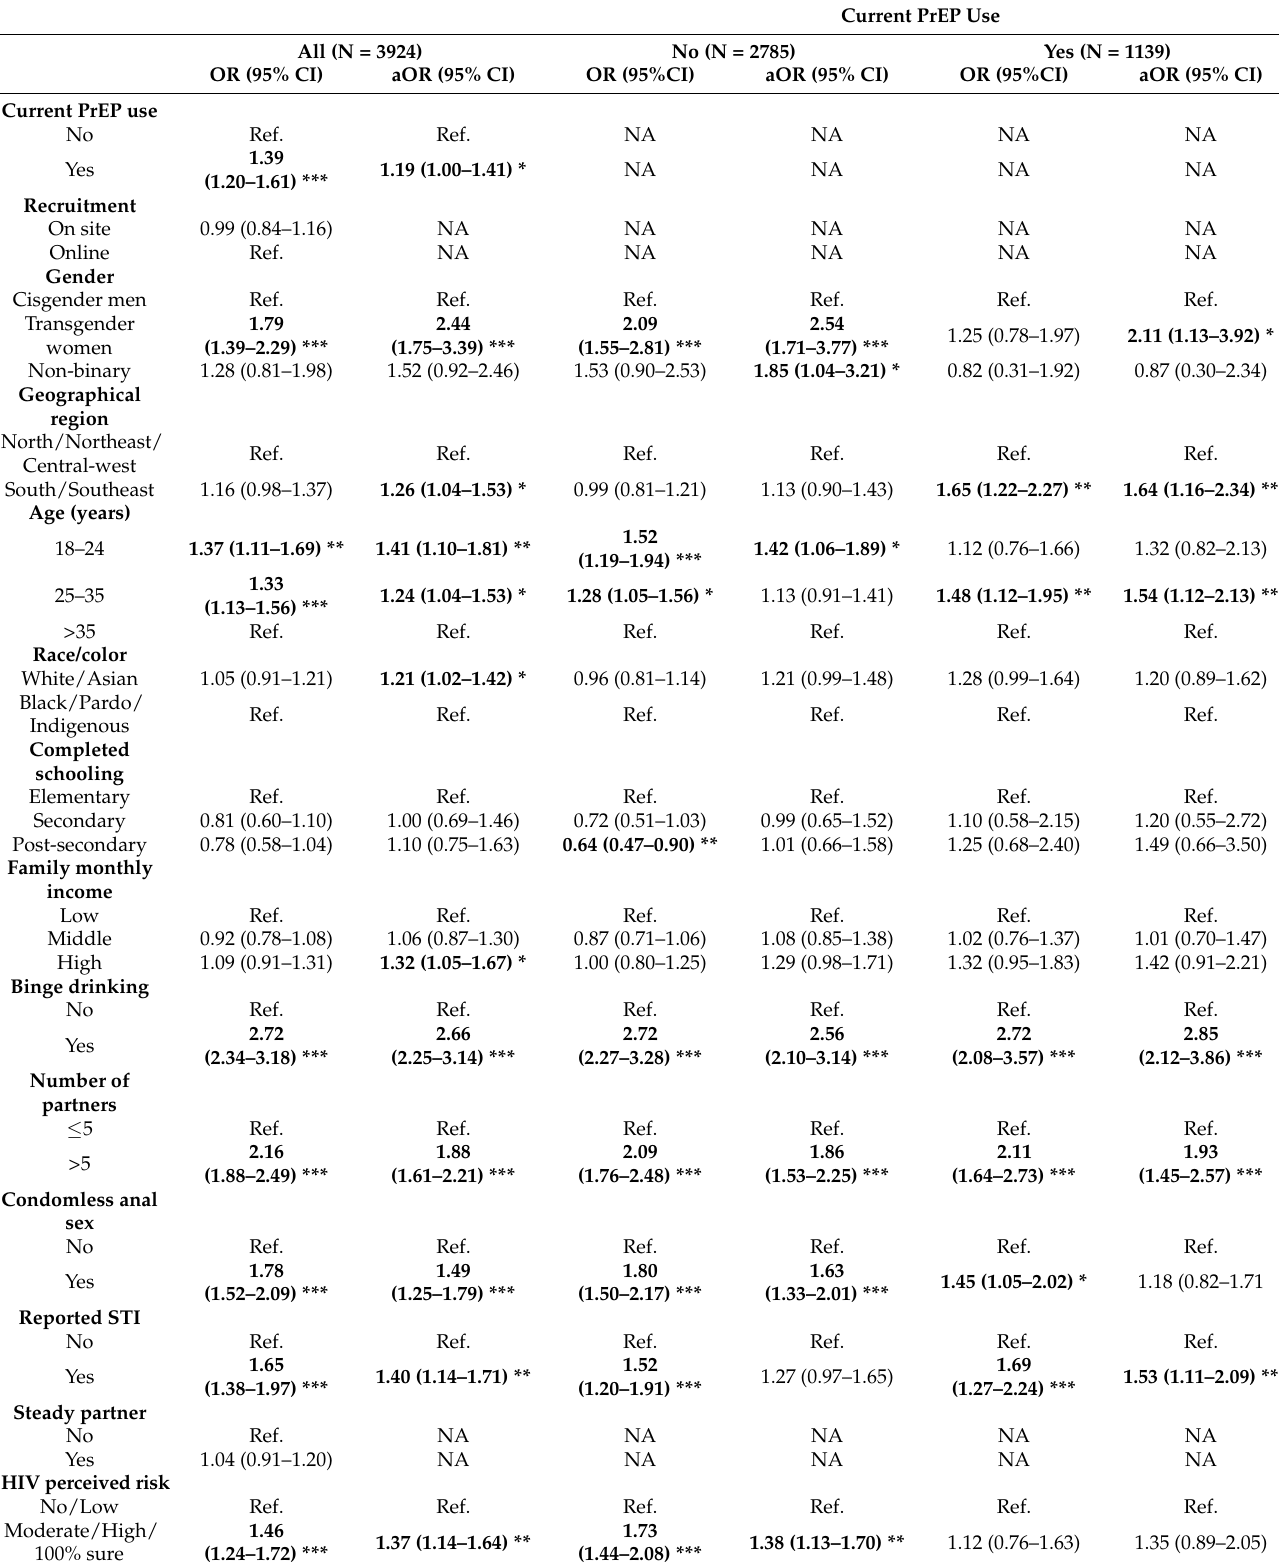
Table 3. Factors associated with SDU, overall and stratified by current PrEP